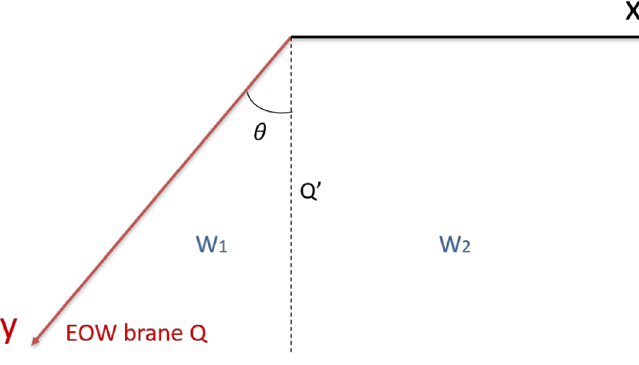
Figure 4 . Bulk decomposition by inserting an imaginary boundary Q 0 .